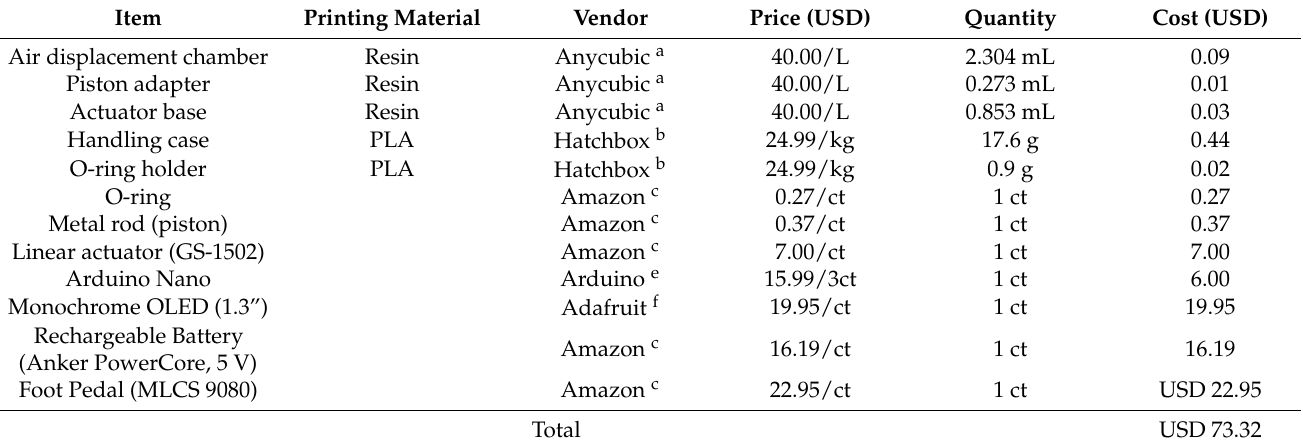
Table 1. Bill of materials including source and cost of components used for prototypes of the Standardized Artificial Insemination Device